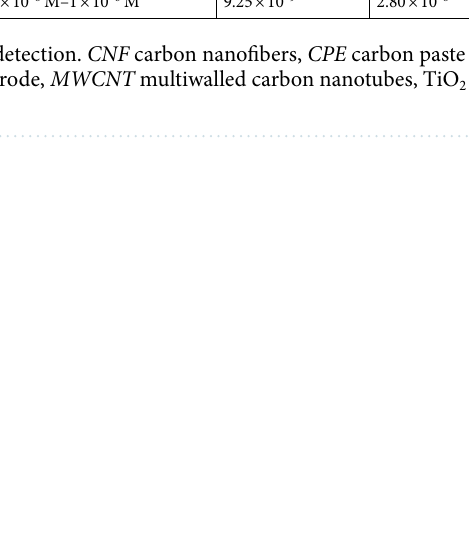
Table 4. Results of recovery for the pharmaceutical dosage form Idamen ® and human serum sample.